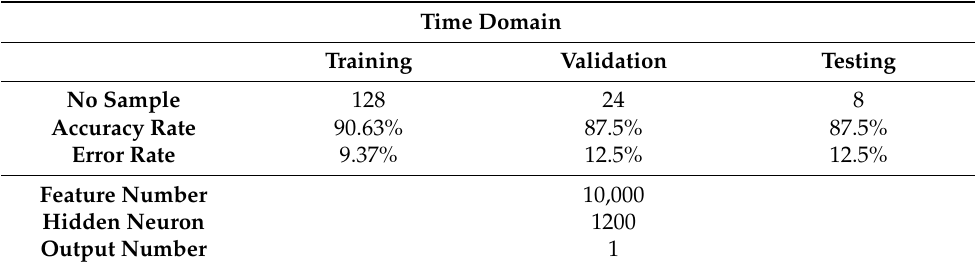
Table 6. Time domain ELM classification result—corona.